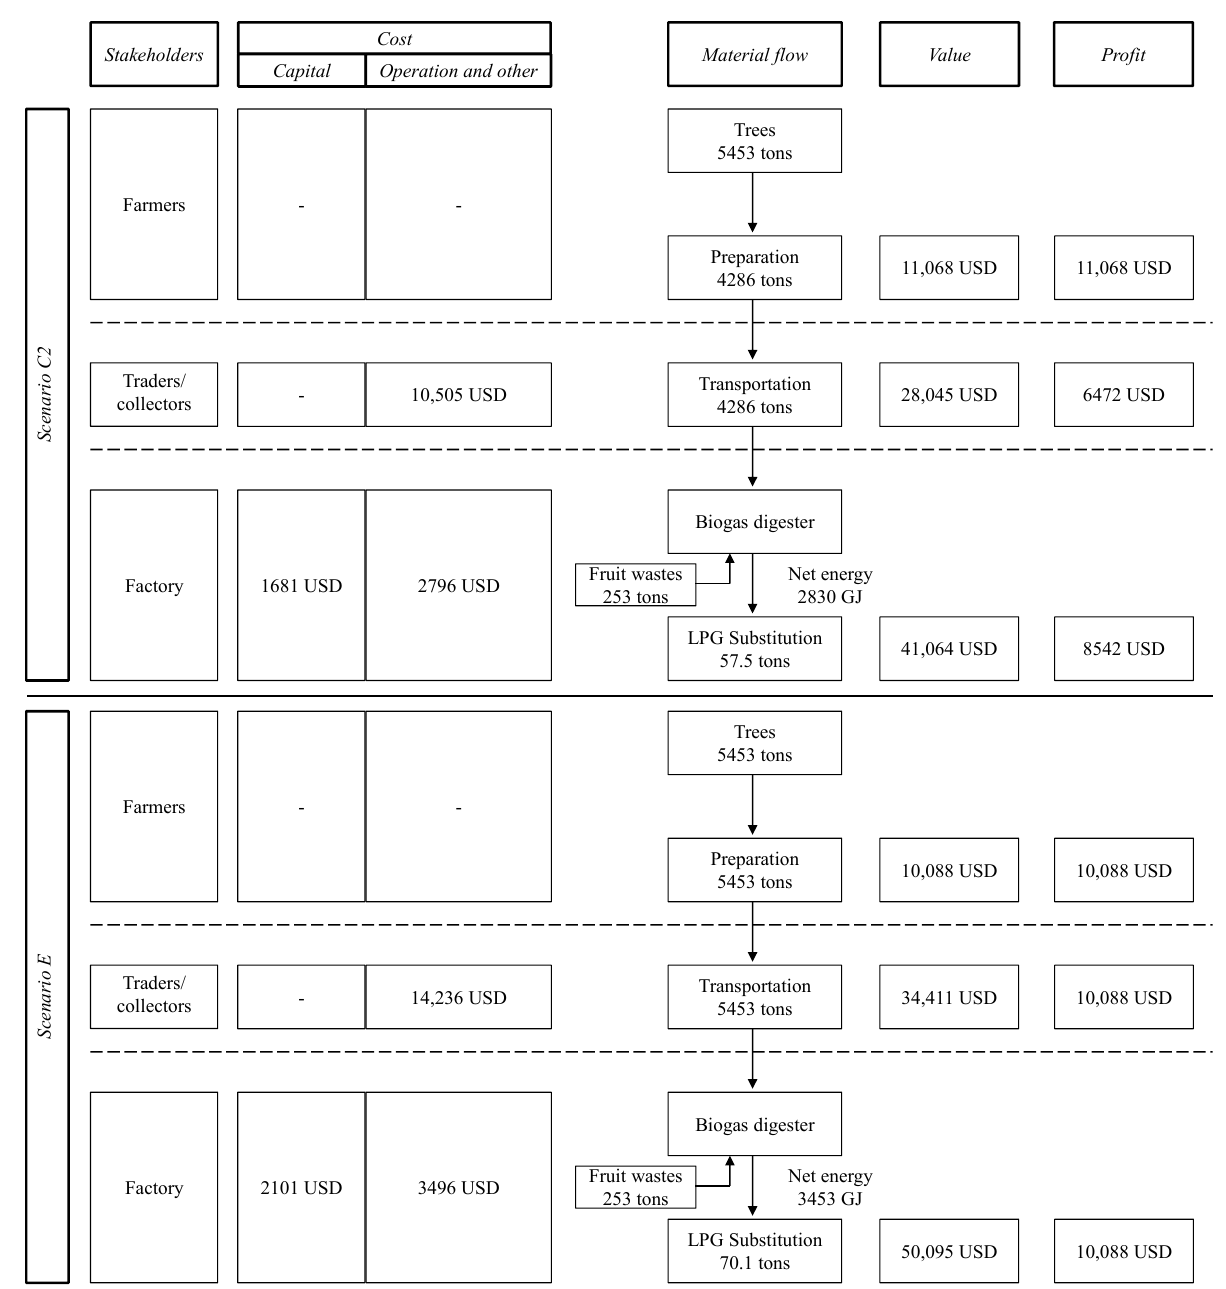
Figure 7. Waste value chain modeling from scenario C2 and scenario E. The quantity of banana residues and its value presented in the proposed waste value Table 4. Added value and profit obtained for each stakeholder in waste value chain could be calculated to be USD 1.9 and 2.6/ton at the farmers’ stage and USD 6.3 and 6.5/ton at the collectors’ stage (Figure 7). The estimated costs at both stages were lower than the cost of banana stem presented in the study by Duque et al. [35], which was USD 17.3/ton. This could be explained by the di ff erence in transportation cost. In contrast, banana residue cost at the farmers’ stage in the present study was higher than that pre- sented by Uchôa et al. [32] and Hossain et al. [33], in which there was no cost for banana residues. The energy produced per ton of biomass could be calculated to be 0.62 and 0.60